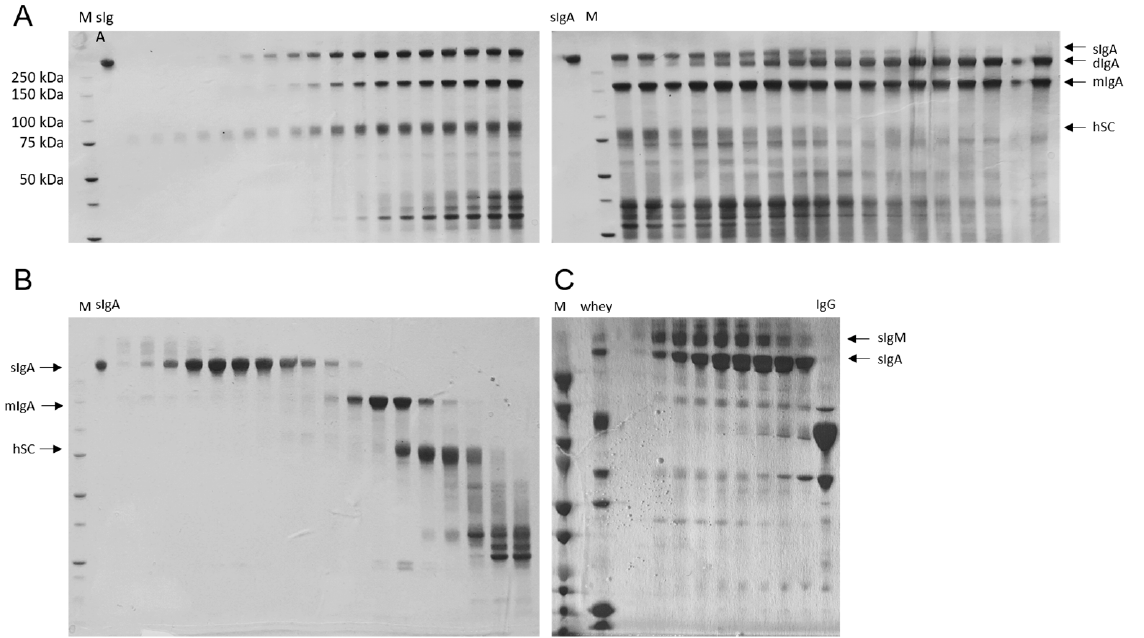
Figure 1. SDS-PAGE of different immunoglobulin-fractions: ( A ) SDS-PAGE analysis of sIgA fractions obtained by anion exchange chromatography. sIgA molecules were eluted under lower salt concentration conditions than dIgA from the AIEx column, allowing their separation. From left to right: subsequently obtained AIEx fractions. ( B ) SDS-PAGE analysis of sIgA obtained by size exclusion chromatography purification. sIgA molecules were efficiently separated by size from mIgA, hSC and other protein contaminants. Fractions were loaded from left to right. ( C ) SDS-PAGE analysis of sIgA-containing fractions extracted from goat whey by chromatography. Fractions were loaded from left to right. M (protein weight marker): BioRad Precision Plus Protein Unstained (A,B), BioRad Precision Plus Protein Dual Color Standard ( C ).